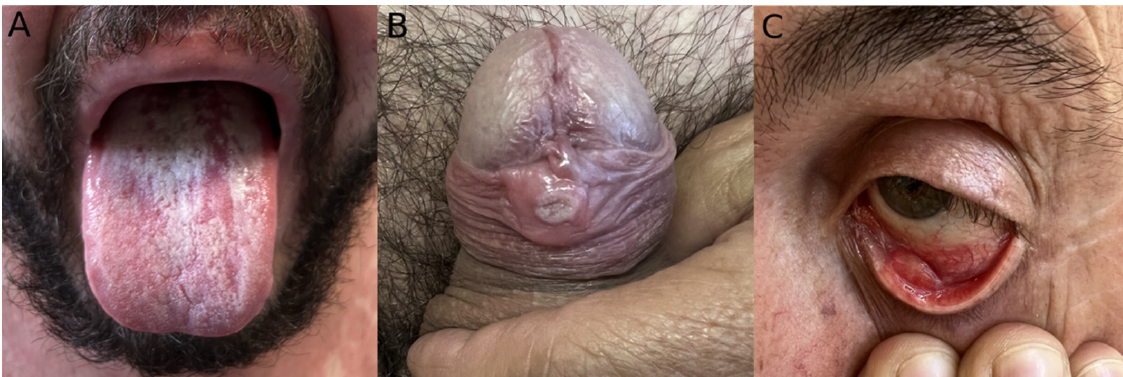
Figure 2. Example of MPX mucosal involvement. ( A ) Oral ulcerations. ( B ) Umbilicated papule in the genital mucosa. ( C ) Palpebral conjunctiva ulceration.